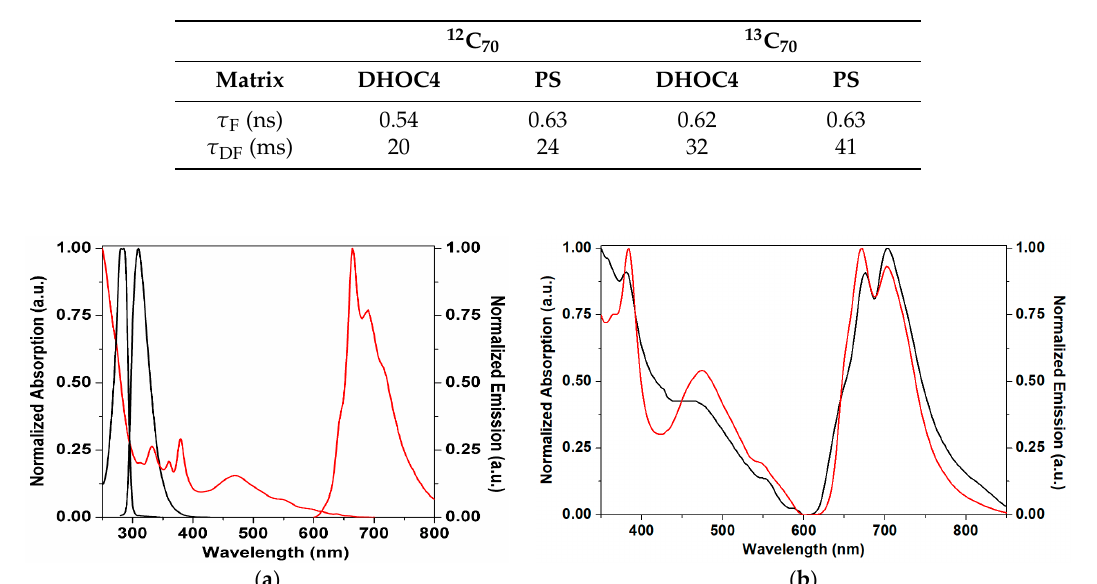
Figure 2. Absorption and emission spectra of DHOC4 (black line) and 12 C 70 (red line) in dichloromethane ( a ) and of 12 C 70 in DHOC4 (black line) and PS (red line) ( b ).